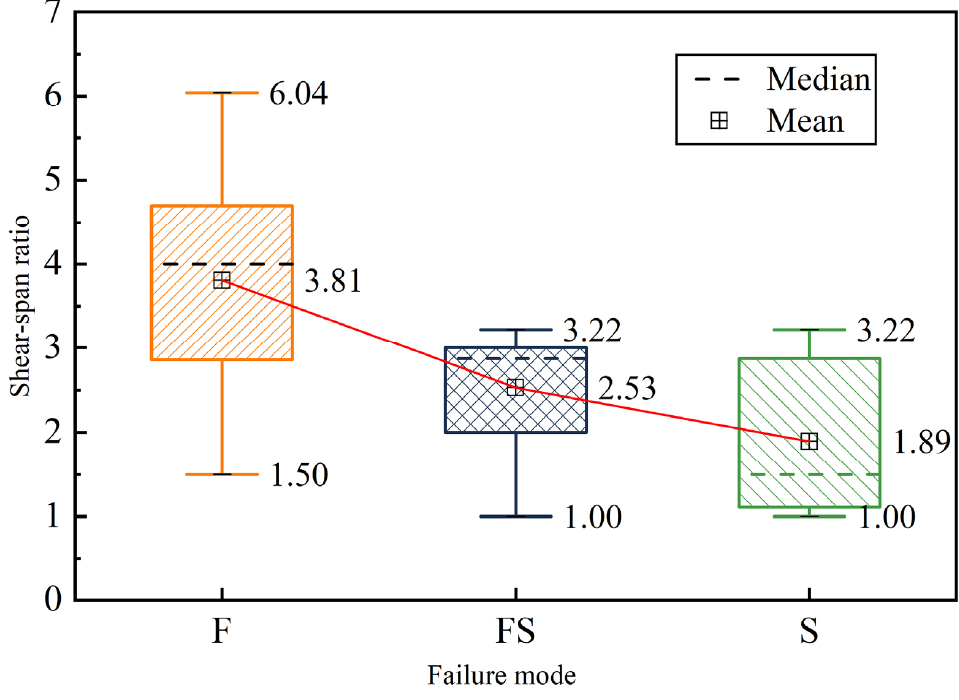
Figure 3. Distribution of shear span ratio in different failure modes.